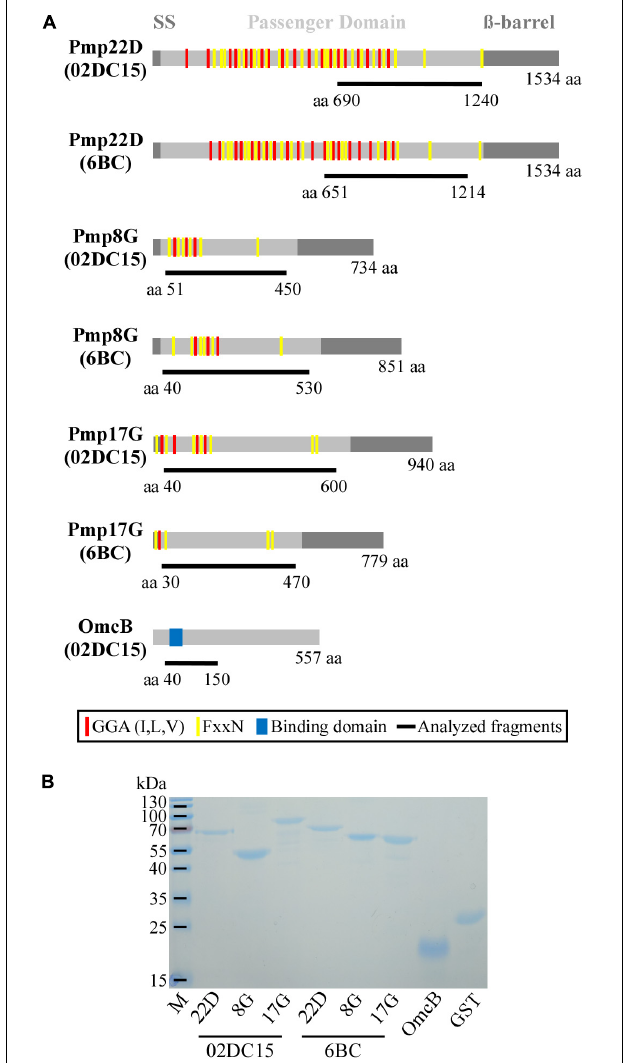
FIGURE 4 | Selected proteins. (A) Schematic representation in scale of Pmp22D, Pmp8G, and Pmp17G from C. psittaci mammalian strain